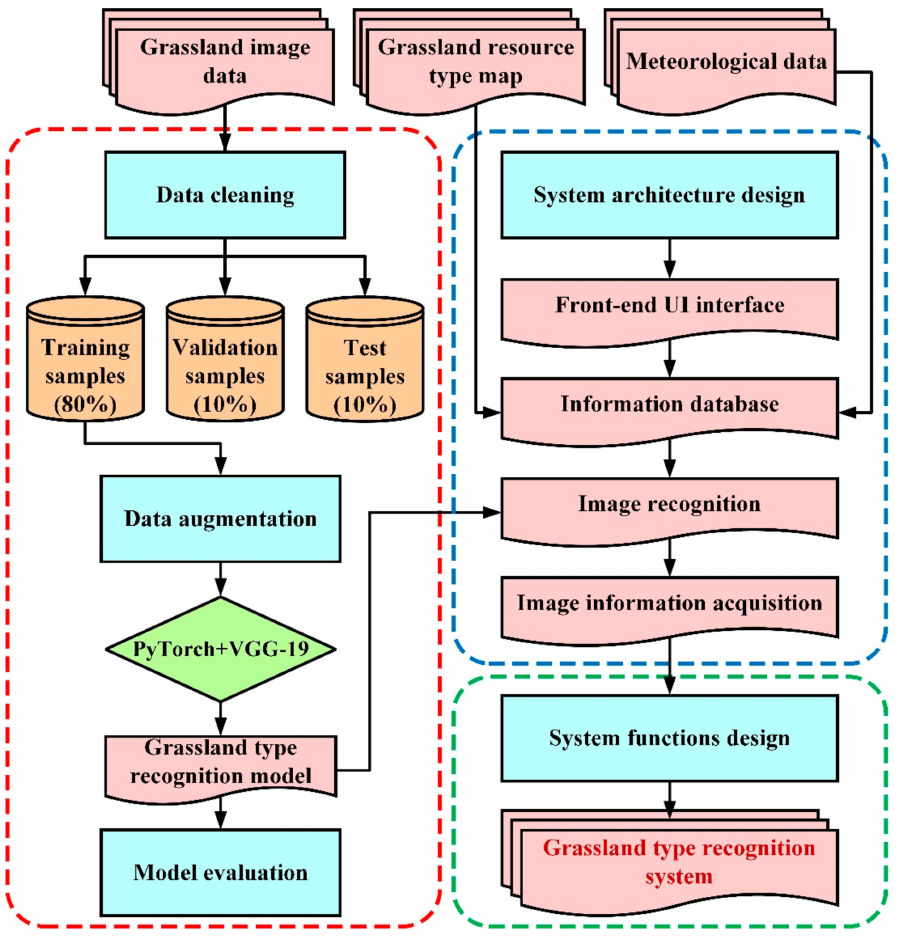
Figure 5. Technology